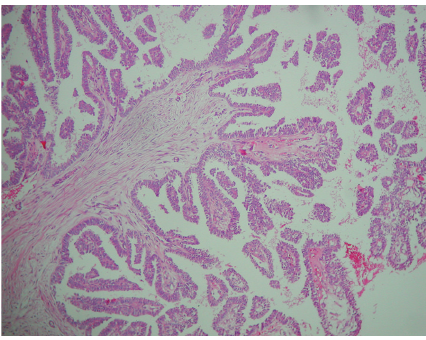
Figure 2: Low power magnification of papillary structures showing multilayer cells covering a fibrovascular stalk (H. E. × 100).